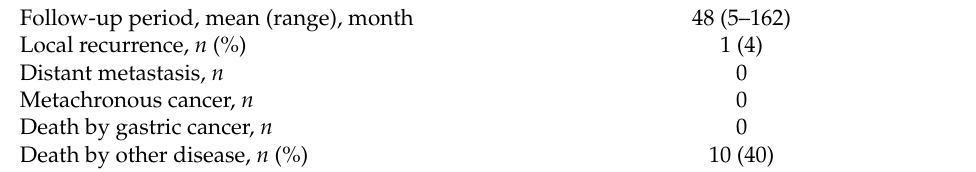
Table 6. Long-term outcomes after endoscopic submucosal dissection.